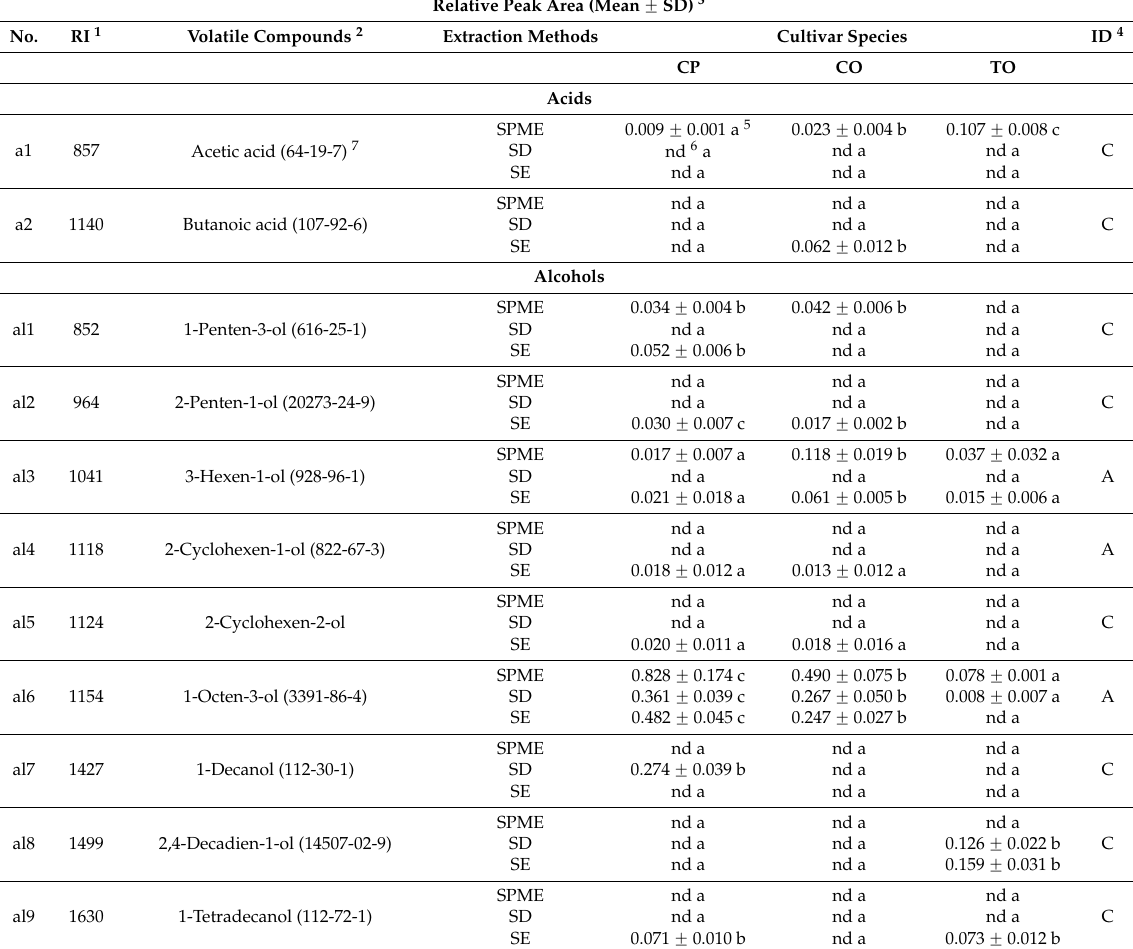
Table 1. Volatile aliphatic and aromatic hydrocarbons of three different cultivars based on different extraction